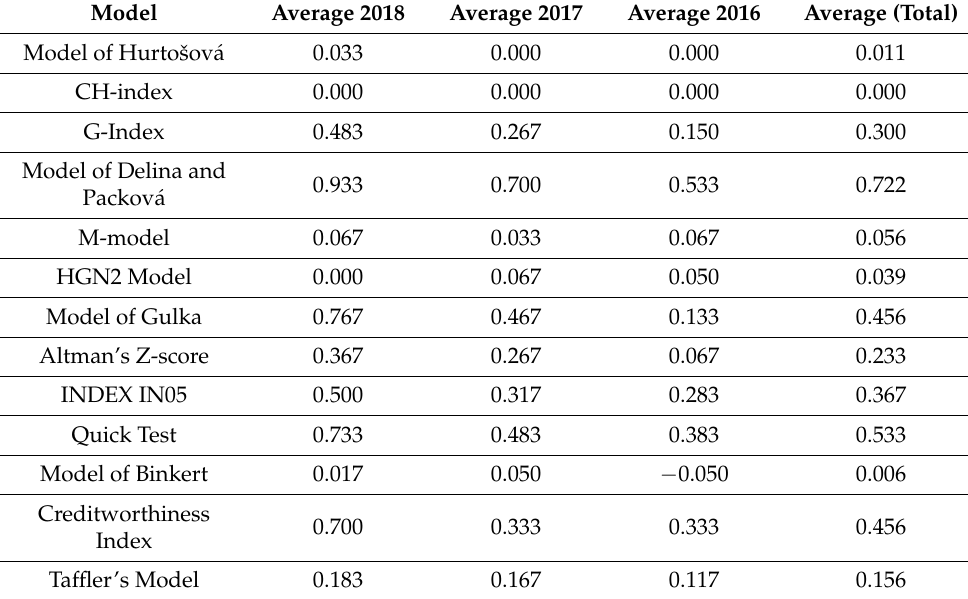
Table A4. Average results of testing models using the Accuracy Adj. measure.